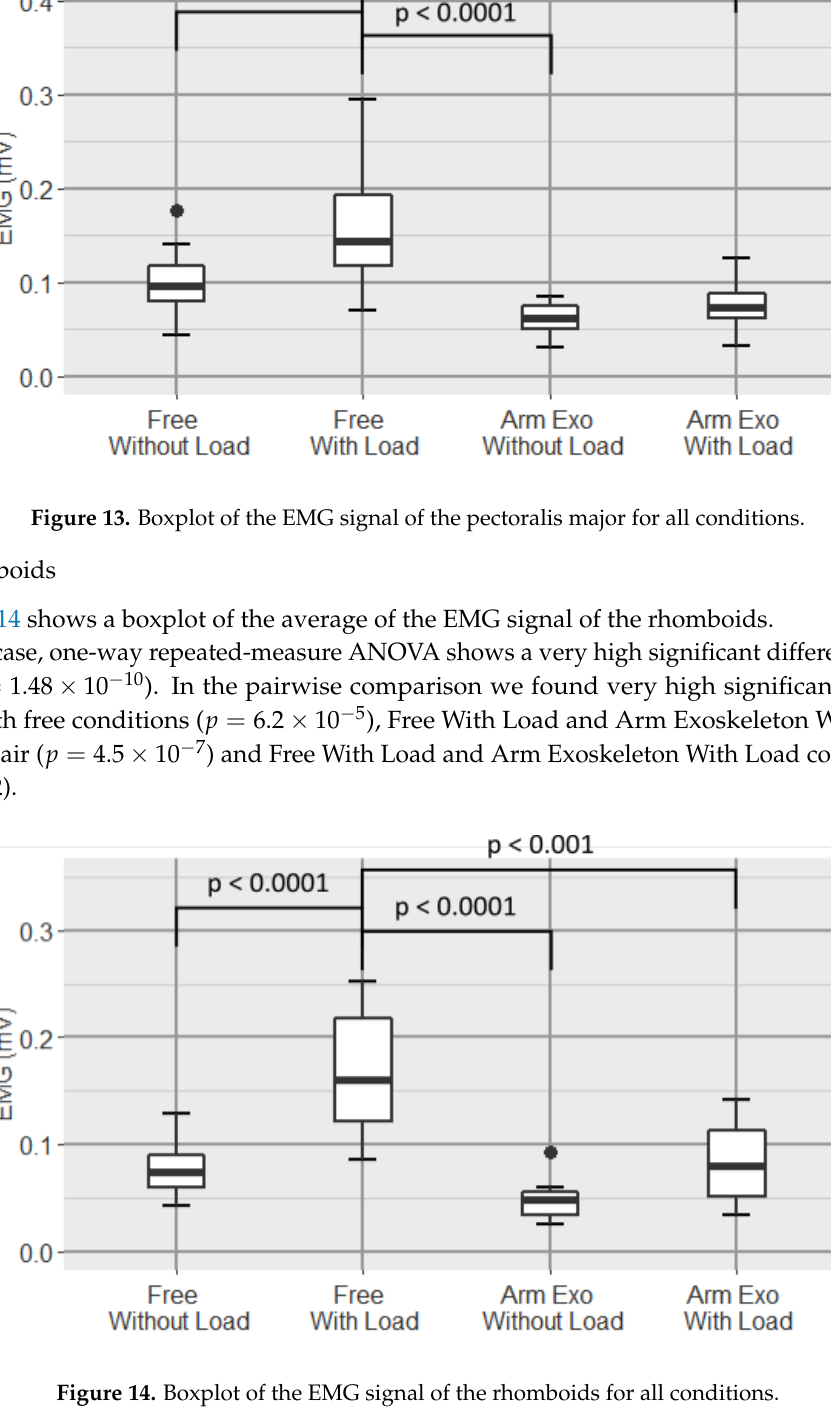
Figure 14. Boxplot of the EMG signal of the rhomboids for all